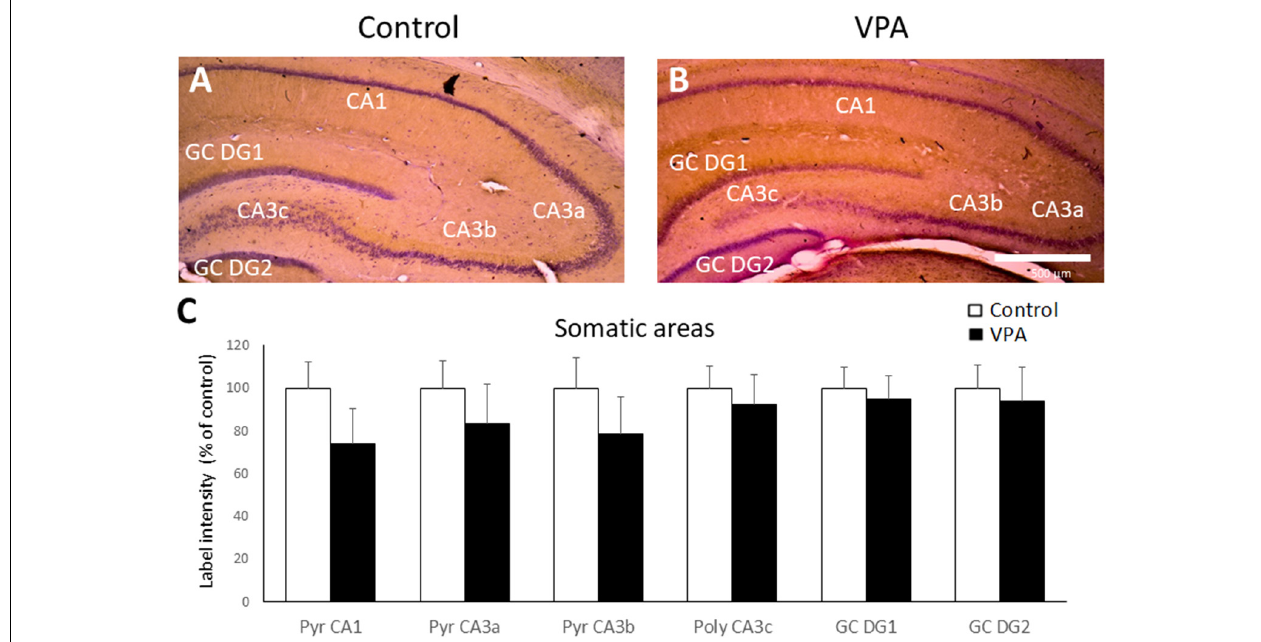
FIGURE 4 | Prenatal VPA treatment produces no effect on BDNF-IR in somatic layers of the hippocampus. Representative microphotographs of Cresyl violet counterstained BDNF Immunohistochemistry (IHC) of controls (A) and VPA-treated (B) rats. Higher magnification of single stained slices was used to quantify the IR label intensity in each hippocampal region (C) . Data represent the mean ± SEM. White and black bars represent controls and VPA-treated animals, respectively. n = 7 for control and VPA-treated rats. Scale bar represents 500 µ m. GC DG1: superior blade of granule cell layer of DG, GC DG2: inferior blade of granule cell layer of DG, Pyr: stratum pyramidale , CA1: cornu ammonis region 1, CA3a-c: cornu ammonis regions 3 a to